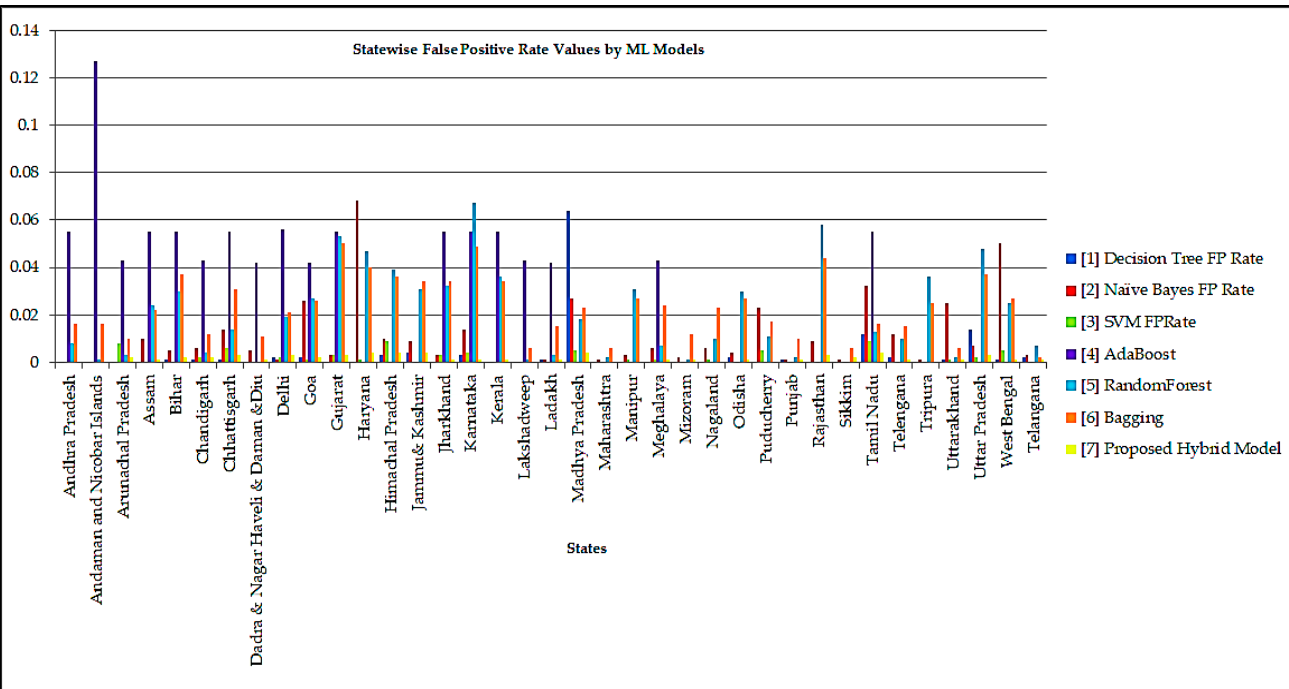
Figure 11. True Positive Rate Predicted by Classification Models for each class.